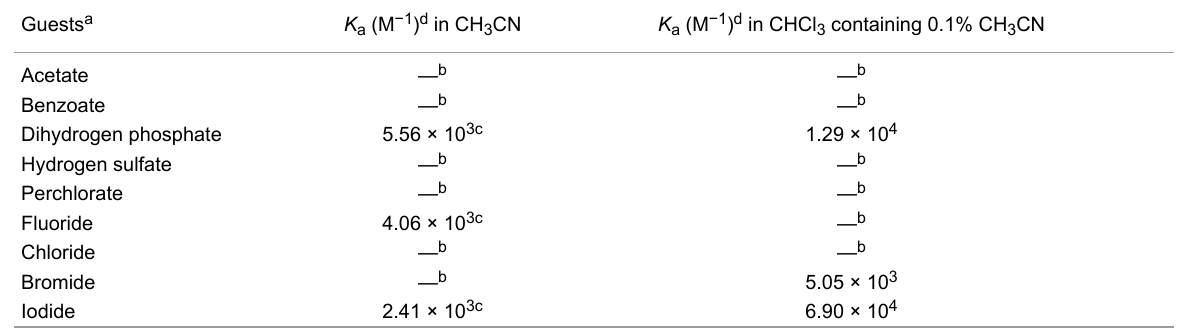
Table 1: Binding constant values of 1 with the guests by fluorescence method.